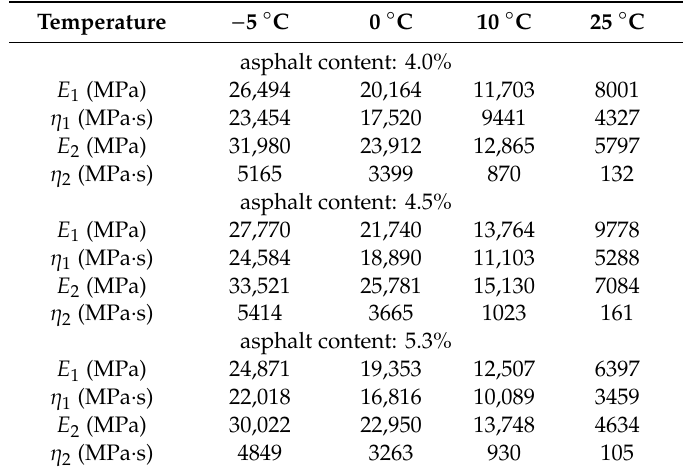
Table 2. Rheological parameters of the Burger’s model obtained for the dynamic 4BP